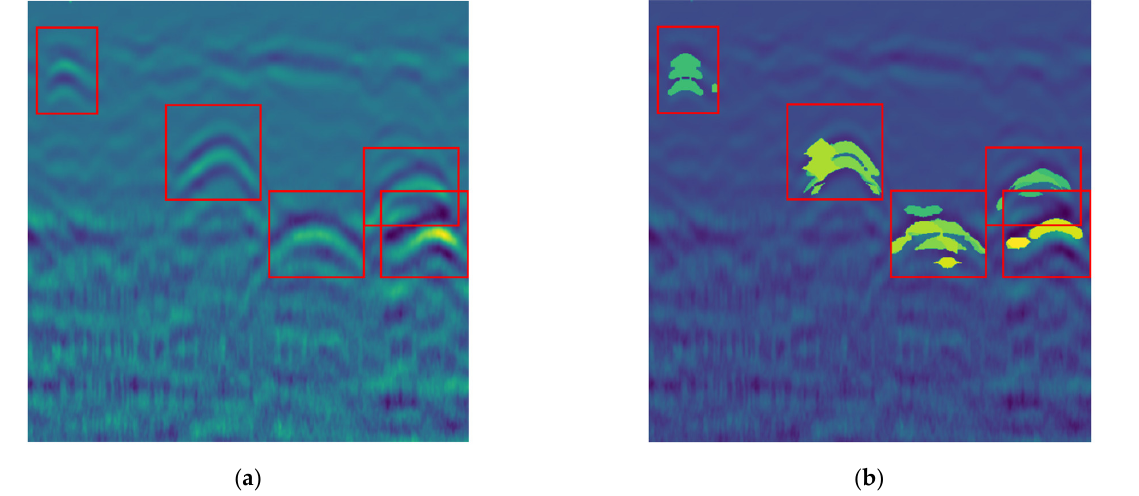
Figure 18. Results of segmentation on the proposal region in field data. ( a ) Hyperbola region detection on an on-site B-Scan image. ( b ) Hyperbola connected area extraction in each proposal hyperbola